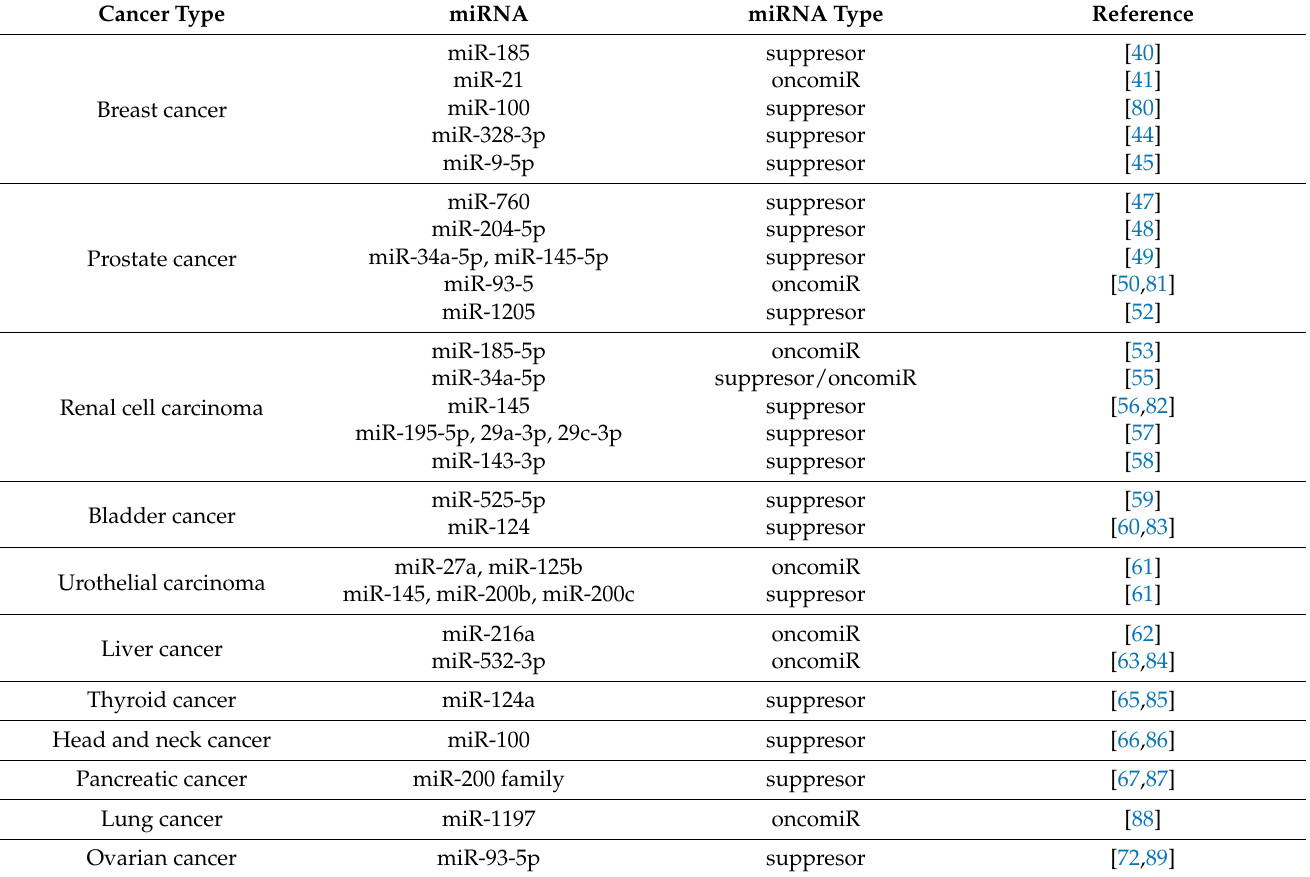
Table 2. Key oncomiRs and suppressor miRNAs connected with androgen receptors in different types of